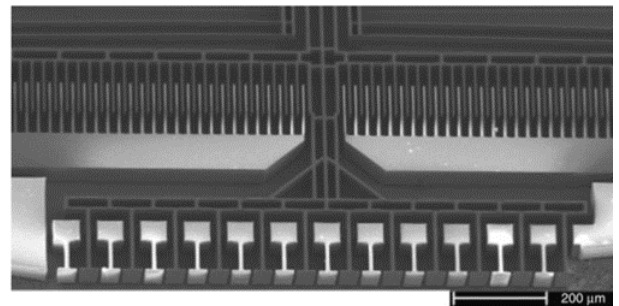
Figure 5. SEM of an in-plane electrostatic actuated Lamellar grating interferometer. (Reprinted with permission from Reference [19] The Optical Society).